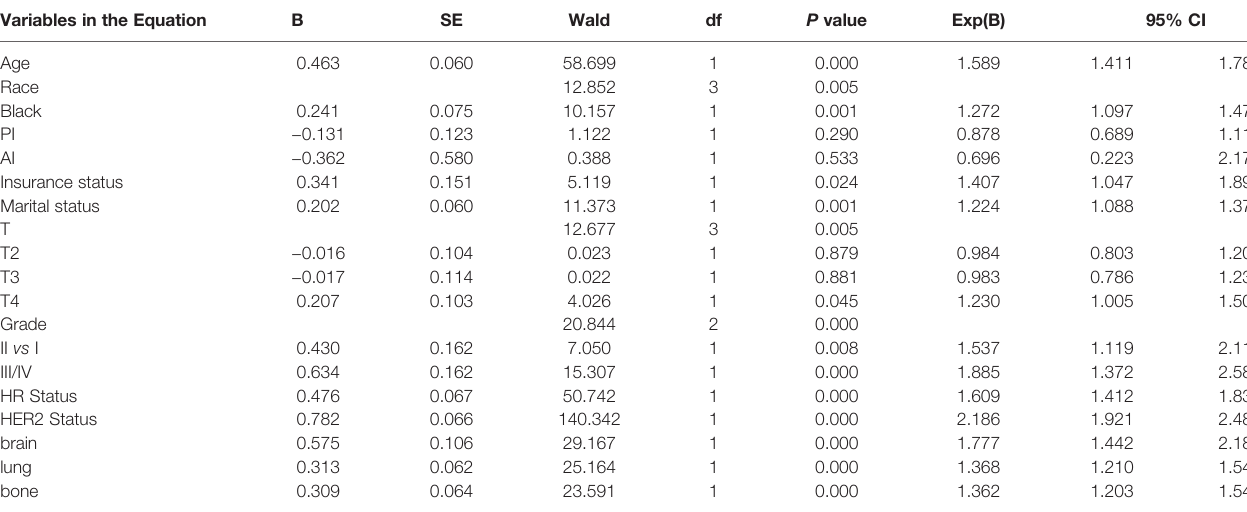
TABLE 2 | Multivariate Cox regression model of training set. Variables in the Equation